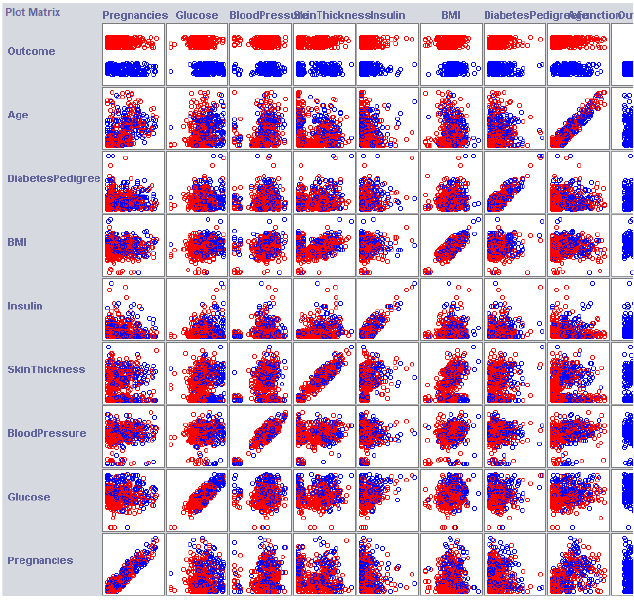
Figure 10. Visualization of